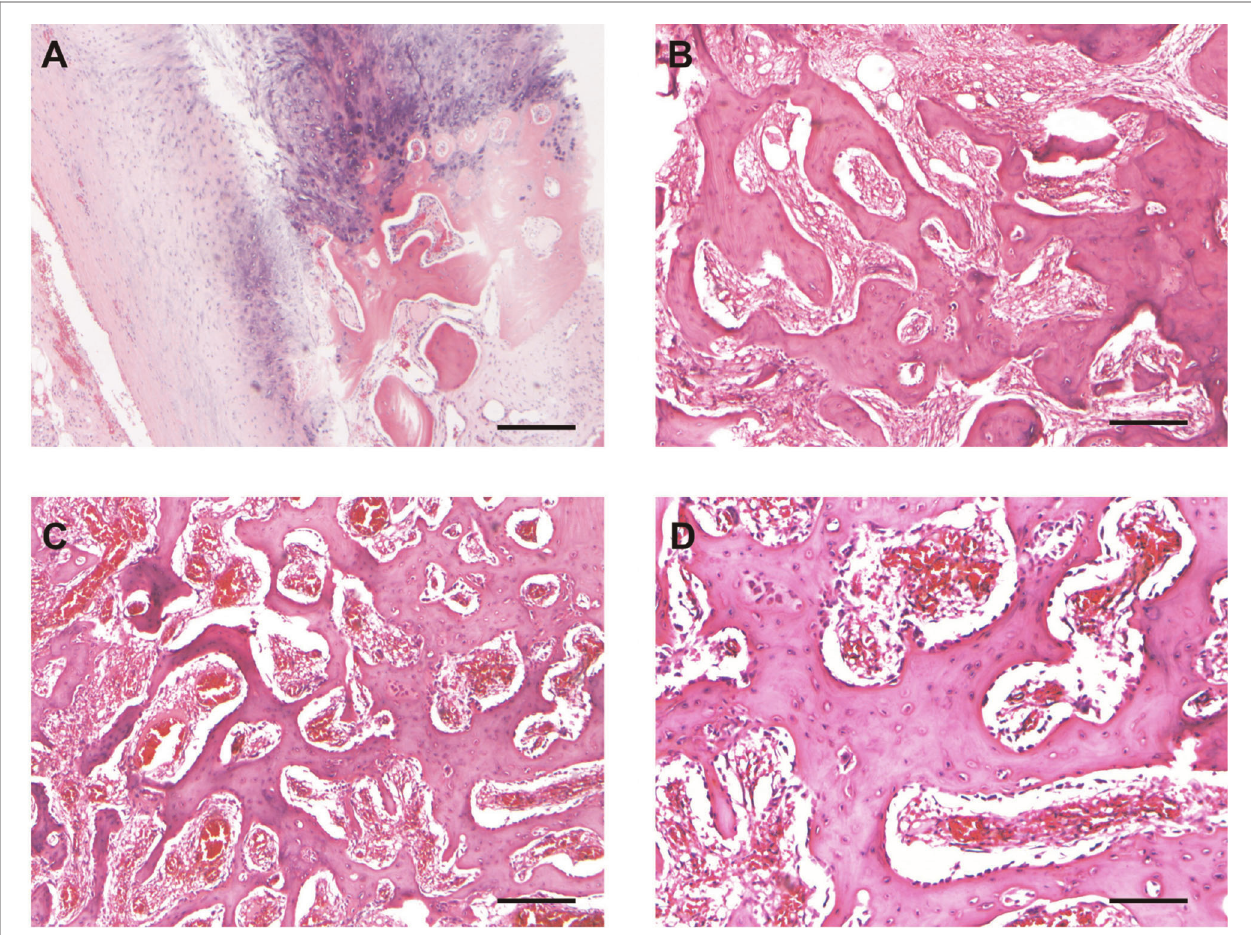
FIGURE 3 | Histopathological characteristics assessed on surgical resection. ( A ) The section shows the reactive, benign chondro-osseous tissue and adjacent fi brous tissue that comprised the ossi fi cation of the ligamentum fl avum specimen. Scale bar, 250 µm. ( B,C ) Representative sections show the anastomosing trabeculae of woven bone with loose fi brovascular stroma with focal hemorrhage and congested blood vessels, consistent with osteoblastoma. Scale bar, 250 µm. ( D ) Area of tumor with prominent osteoblastic rimming. Scale bar, 125